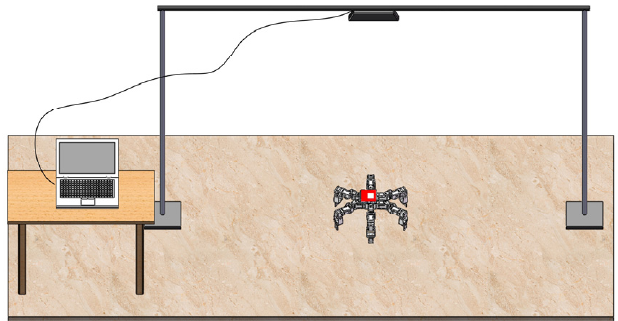
Figure 12. The stability margin of four different gaits within a single motion period: ( a ) the wave gait; ( b ) the tetrapod gait; ( c ) the tripod gait; ( d ) the self ‐ turning gait.